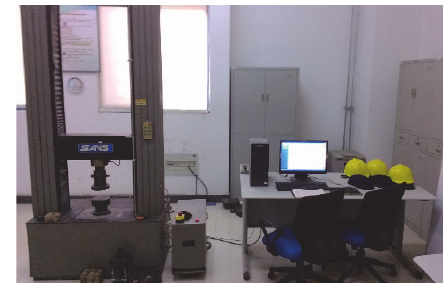
Figure 4: SANS test system.